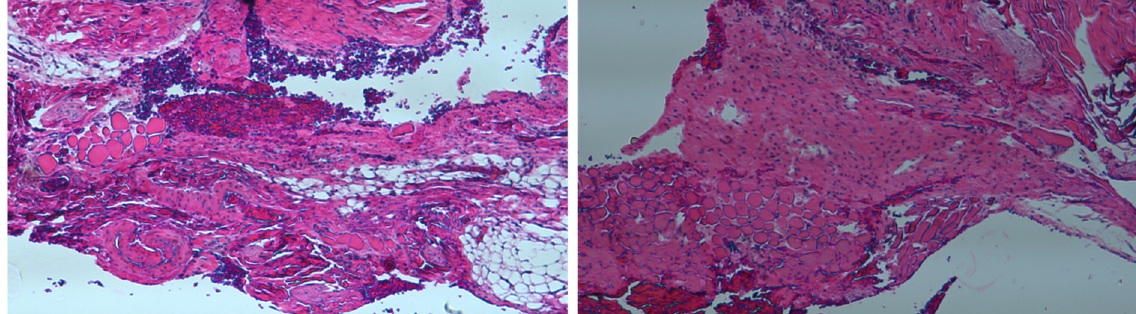
Figure 15. The H&E histological images (magnification: 4.5×) in Control group at day 7 ( left ) and day 14 ( right ). The inflammatory tissue reaction was noted.